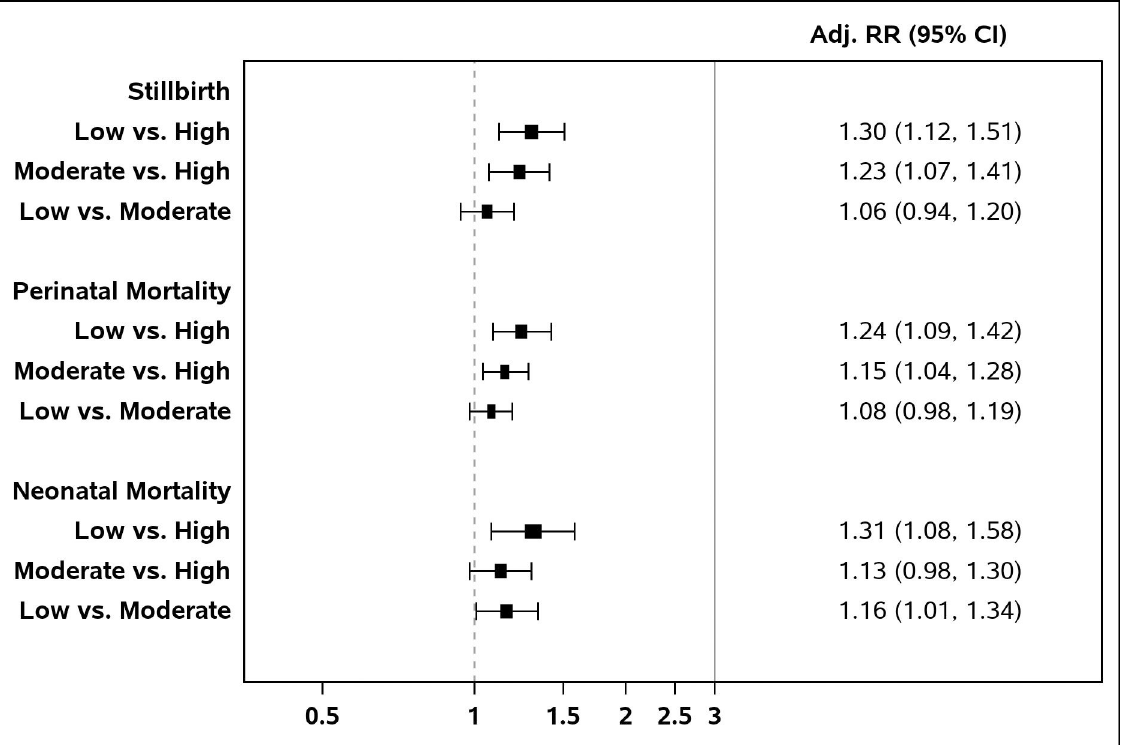
Fig 2. Adjusted relative risks (95% confidence intervals) of outcomes by SES: All sites. Relative risks are adjusted for SES category, site, maternal age, parity, formal education level, BMI category, and facility birth.